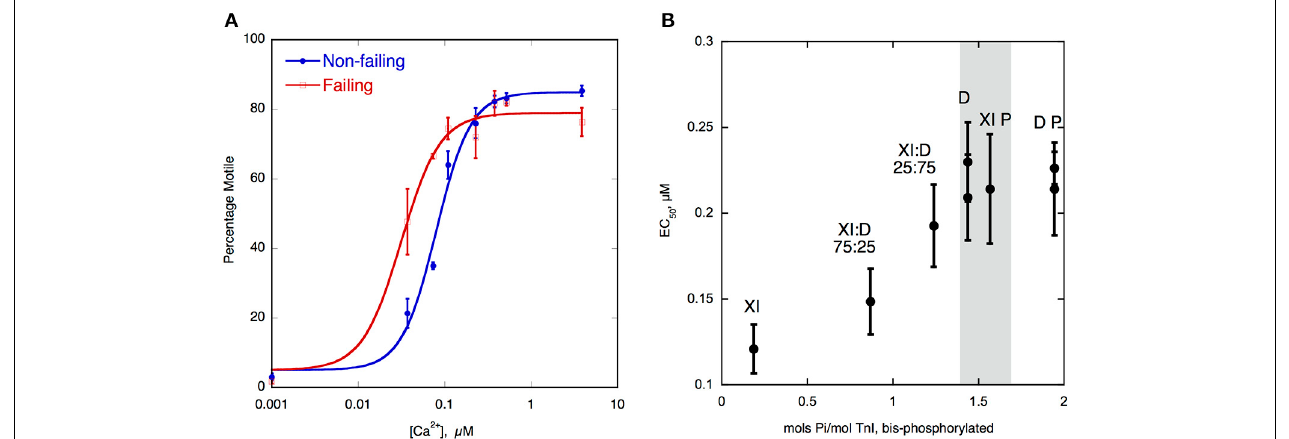
FIGURE 2 | (A) Ca 2 + -regulation of thin filament motility by non-failing (donor) and failing heart troponin. Thin filament motility was measured by motility assay over a range of [Ca 2 + ] in paired cells. The percentage of filaments motile is plotted as a function of [Ca 2 + ] for a representative experiment. In blue lines and points, non-failing thin filaments, red lines and open points, failing thin filaments. TnI phosphorylation levels are shown in Figure 1B . The points ± s.e.m. are the mean of four determinations of percentage motile measured in one motility cell. The curves are fits of the data to the Hill equation (Messer et al., 2014). (B) Relationship between EC 50 for